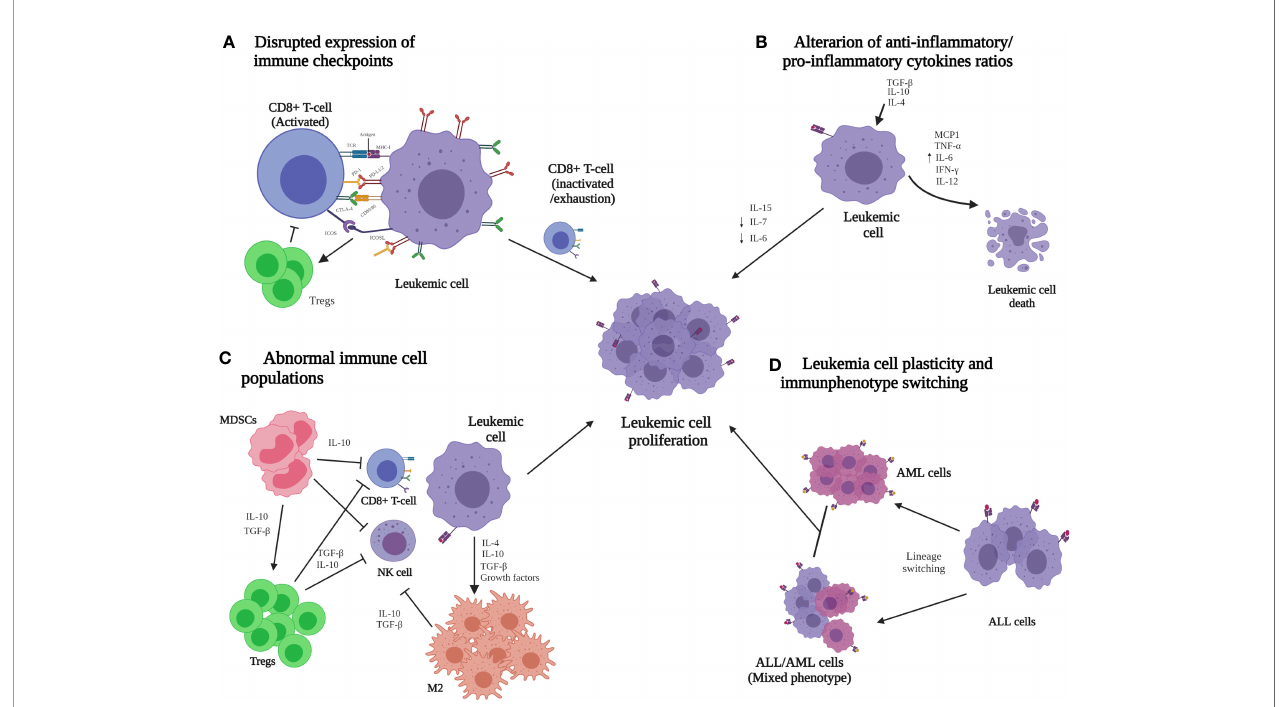
FIGURE 2 | Immune evasion mechanisms that are potentially involved in the progression of acute lymphoid leukemia (ALL). (A) Low MHC-I and co-stimulatory ligands but high co-inhibitory lead to the inactivation or depletion of the CD8+ T-cell cytotoxic function. (B) Abnormal expression of anti-in fl ammatory cytokines (TGF- b , IL-4, and IL-10) reduces the cytotoxic T lymphocyte (CTL) population, and the pro-in fl ammatory cytokines (MCP1, TNF- a , IL-6, IL-12, and IFN- g ) are responsible for malignant cell destruction. (C) Immune cell enrichment, such as MDSCs, Tregs, and M2 macrophages, generates a favorable microenvironment for ALL cells and inhibits the activation and differentiation of CTLs and natural killer cells. (D) The plasticity of ALL cells leads to immunophenotype switching, which can reprogram immune evasion pathways. It has been proposed that these mechanisms could together contribute to the dissemination and progression of ALL. ALL, acute lymphoblastic leukemia; AML, acute myeloid leukemia; CD, cluster differentiation; CTLs, cytotoxic T lymphocytes; CTLA-4, cytotoxic T-lymphocyte-associated protein 4; ICOS, inducible co-stimulator; ICOS-L, inducible co-stimulator ligand; IFN- g , interferon gamma; IL, interleukin; M2, M2 macrophages; MCP1, chemoattractant protein-1; MDSC, myeloid-derived suppressor cells; MHC-I, major histocompatibility complex class I; NK, natural killer; PD1, programmed death 1 ligand; PD-L1/2, programmed death 1/2 ligand; TCR, T-cell receptor; TNF- a , necrosis factor alpha; Treg, regulatory